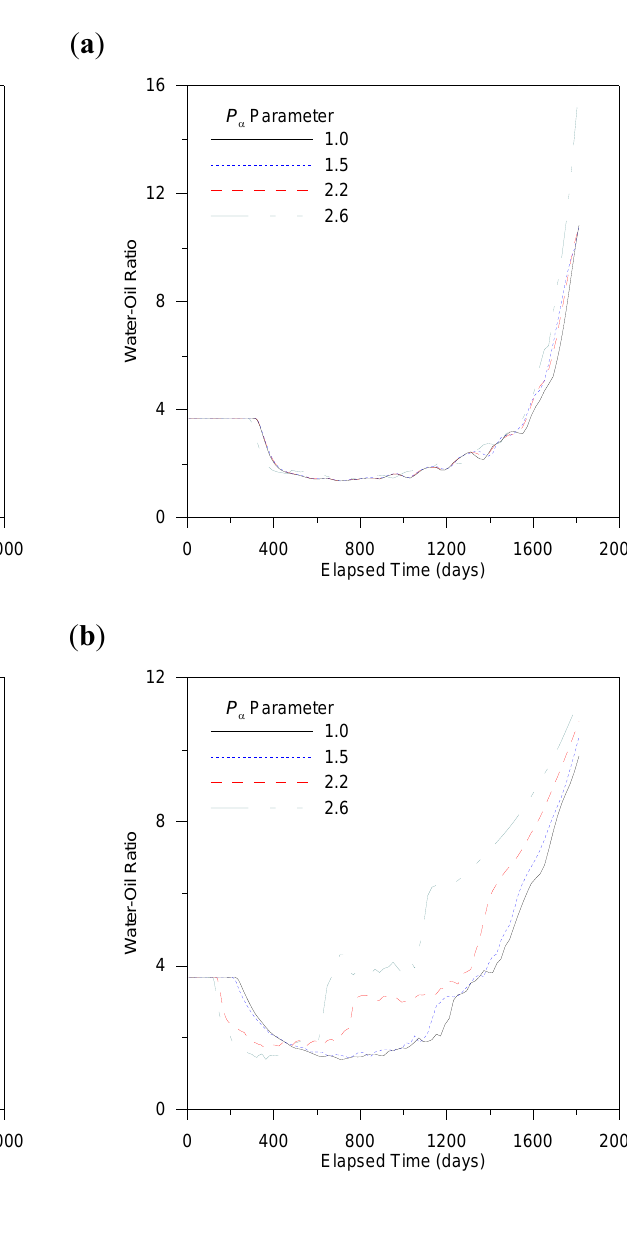
Figure 5. History of production wells obtained from simulations for 0/ = different P and permeability heterogeneity. ( a ) α